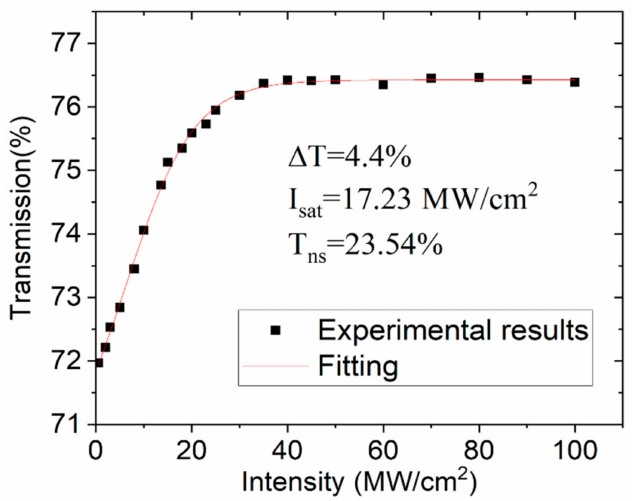
Figure 2. Nonlinear transmittance curve of the SnSe 2